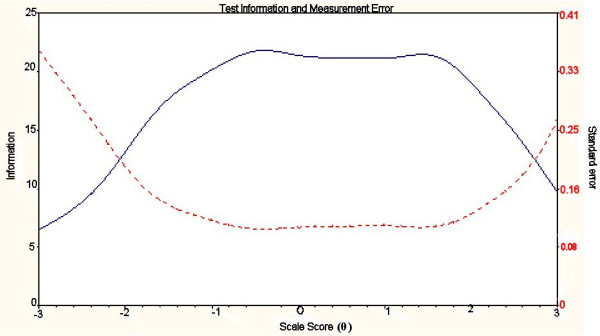
Total information across the construct for Ab-A. Test information curve - solid line; Standard error curve - dotted line.